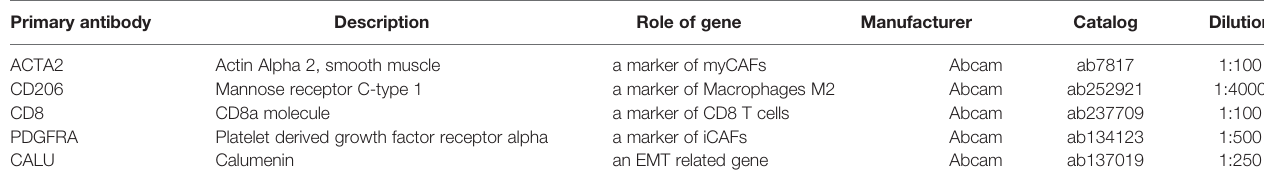
TABLE 2 | Primary antibodies used in IHC